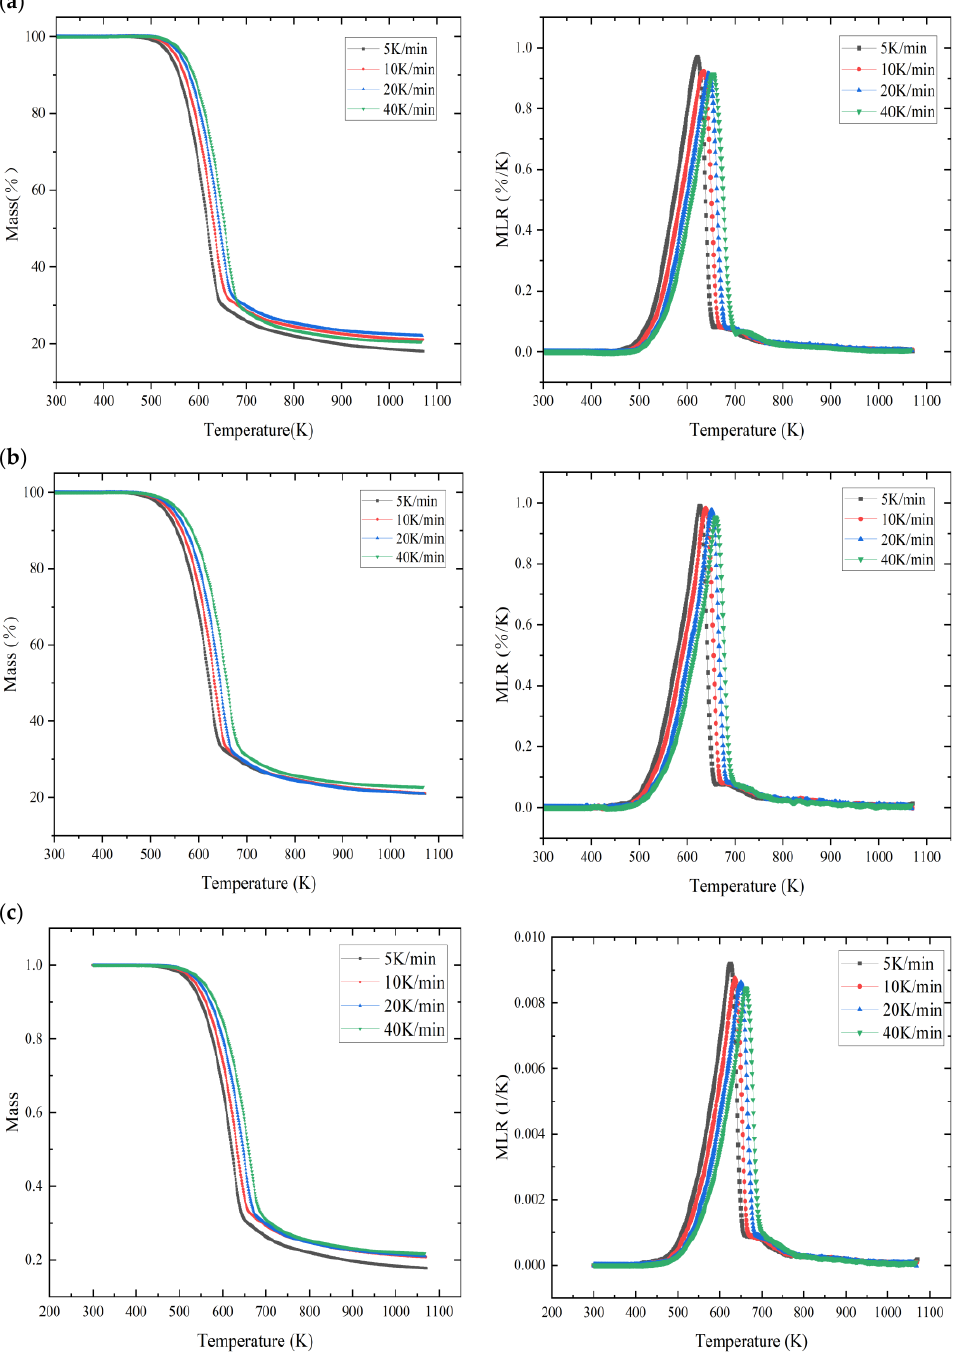
Figure 3. Mass loss (left) and mass loss rate (right) of Chinese fir under four heating rates in nitrogen atmosphere ( a ) Natural aging — 10; ( b ) Natural aging — 70; ( c ) Natural aging — 100. Figure 4a – d show the mass loss and mass loss rate of samples with different natural aging degrees under four heating rates in the nitrogen atmosphere. The mass loss curve of Chinese fir with different natural aging times has a similar trend. The mass loss rate curve has only one peak, because the main decomposition or transformation component of Chinese fir is hemicellulose before 600 K [17]; whereas, the content of hemicellulose in Chinese fir is less, with only 12% on average, so only one peak can be observed on the mass loss curve. Regardless of the heating rate, the thermogravimetric curve has a similar trend, but the onset temperature of the sample thermal weight loss and the temperature